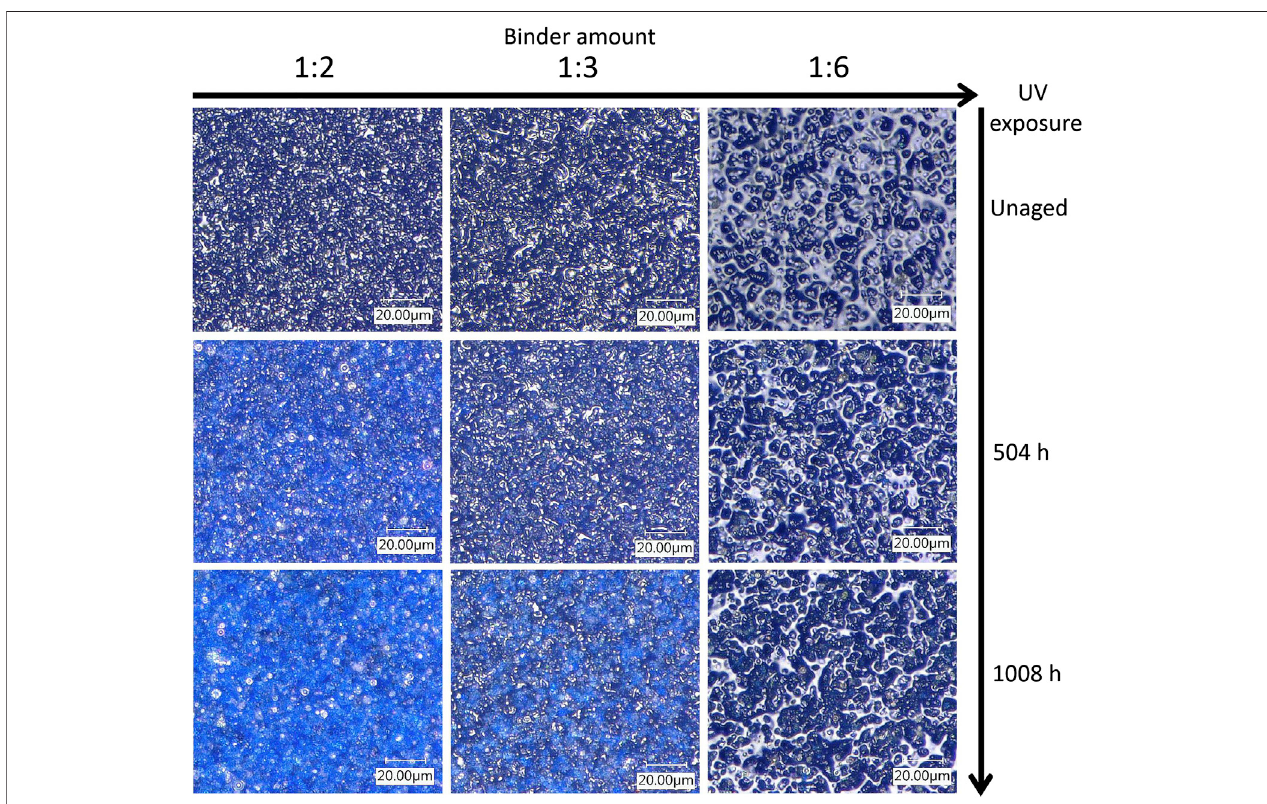
FIGURE 2 | Morphological overview by 3D image (1,000 × ) of PB29 alkyd samples. From left to right, the samples are displayed according to their different P/BM ratios, whereas the images from top to bottom depict the unaged, 504, and 1,008 h aging.